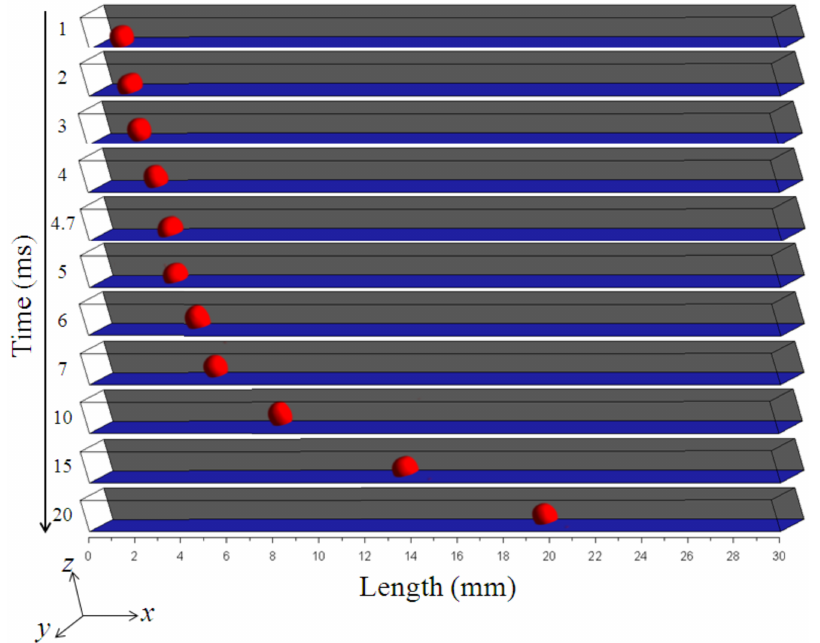
Figure 11. Water transport and dynamics in the flow channel with the channel surface contact angle of 140 ◦ , corresponding to Case 6 given in Table